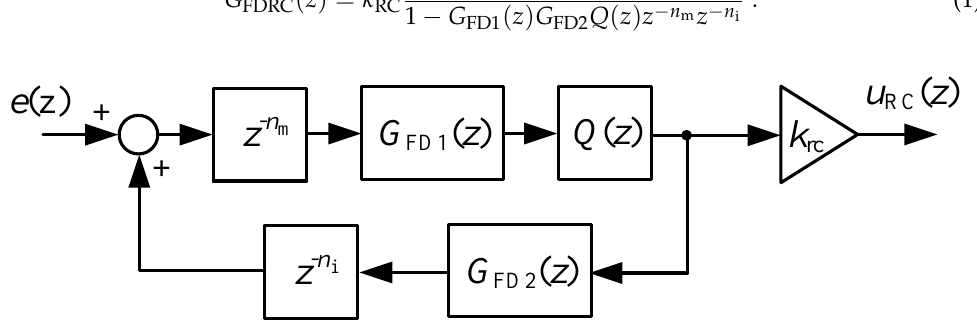
Figure 2. Scheme of the fractional delay repetitive controller.